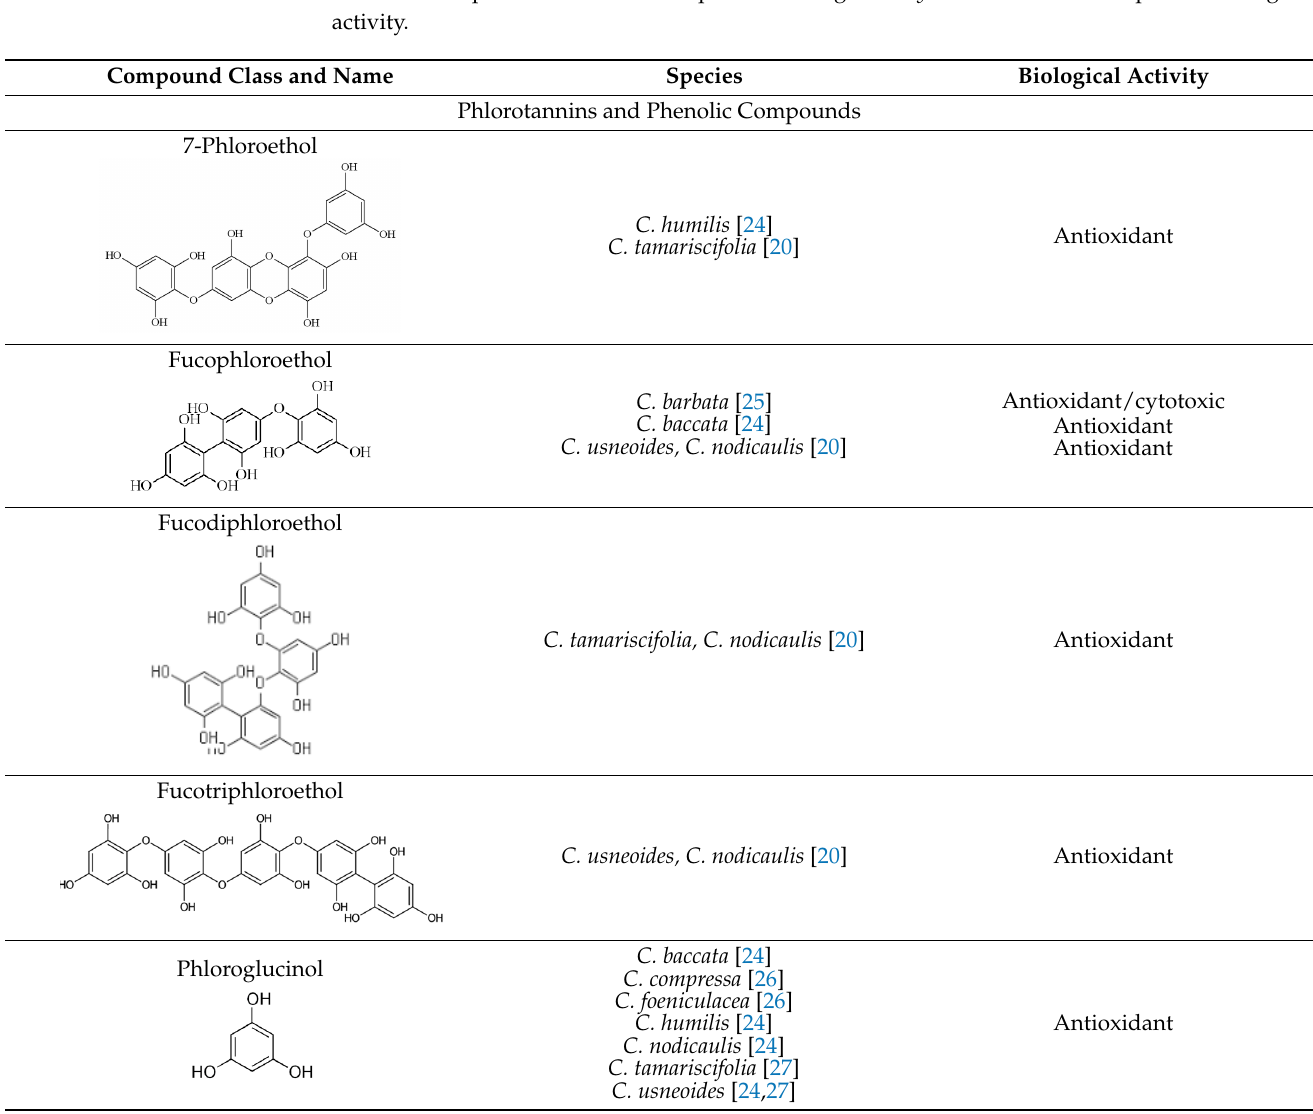
Figure 2. Example of specimen Ericaria selaginoides , previously designated as Cystoseira tamariscifolia, ( left ) collected from the north coast of Portugal ( right ). Table 1. Compounds identified in species of the genus Cystoseira and their respective biological activity.